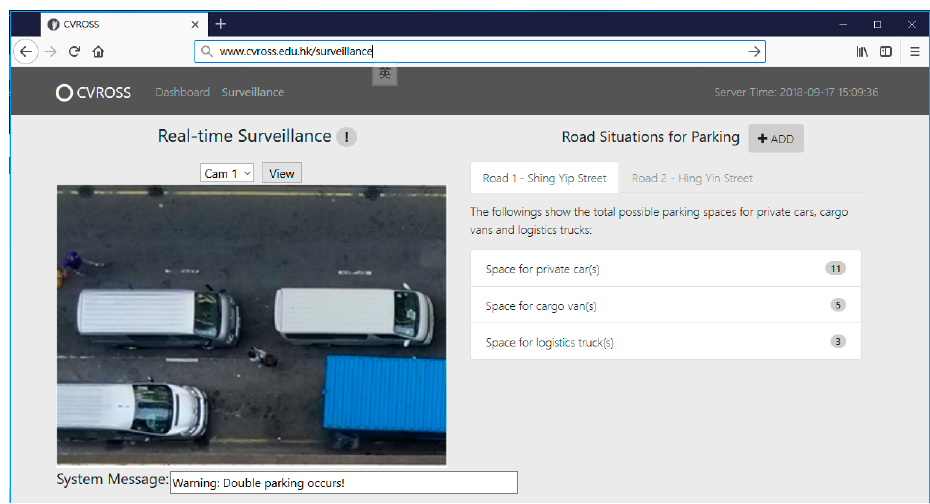
Figure 17. Overview of the interface design for information visualization.